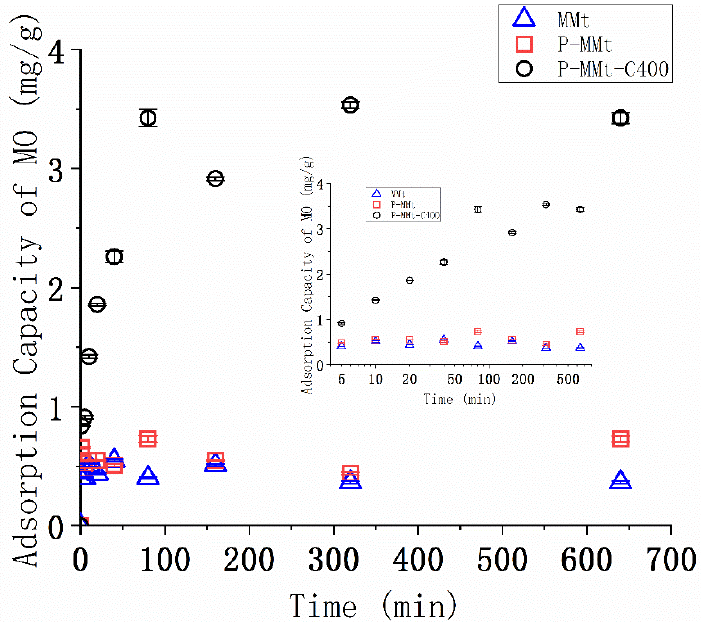
Figure 7. The MO adsorption (50 mL of 5 mg/L solution) of MMt, P-MMt, and P-MMt-C400 at different contact time intervals; SD is added as an error bar to each point, n = 3. The x-axial of the inserted figure is in log scale.